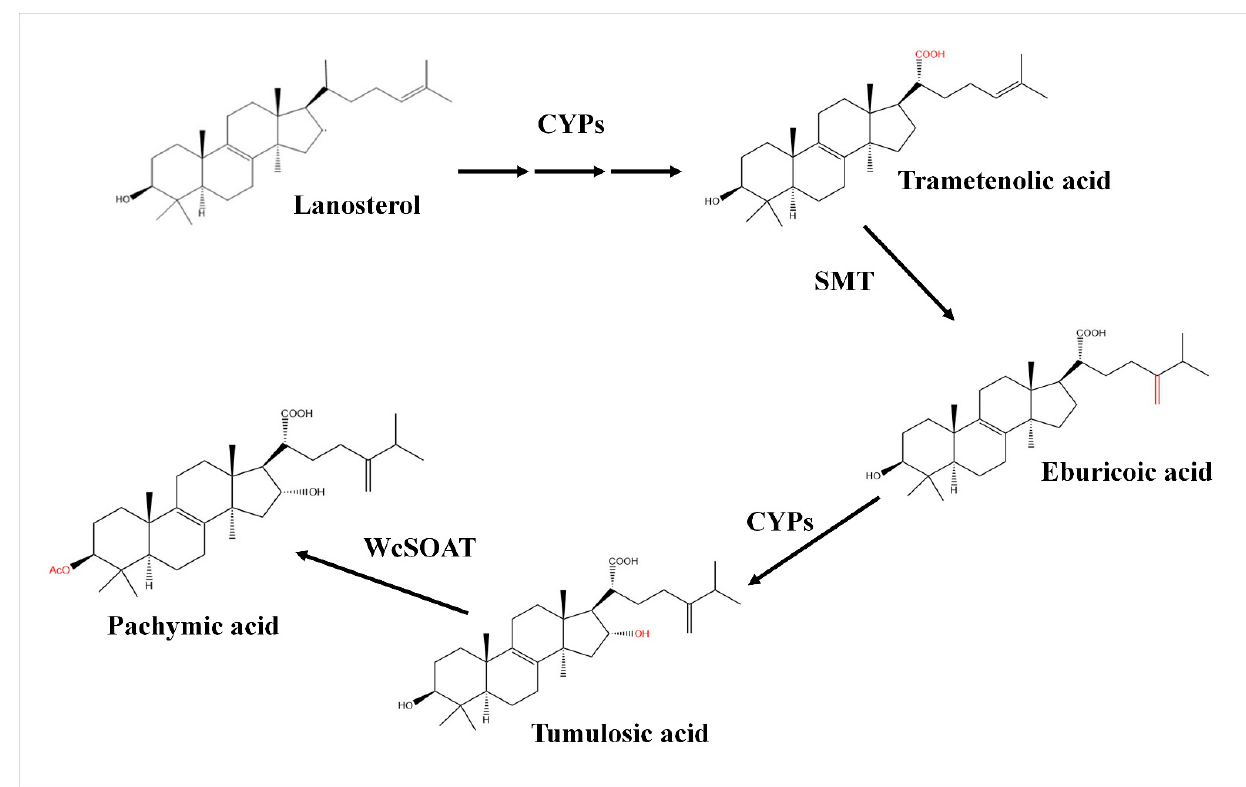
Figure 1. The putative biosynthetic pathway from lanostane to pachymic acid in W. cocos. CYPs: cytochrome P450 family protein; SMT: sterol C-24 methyltransferase; WcSOAT: W. cocos sterol O- acyltransferase.